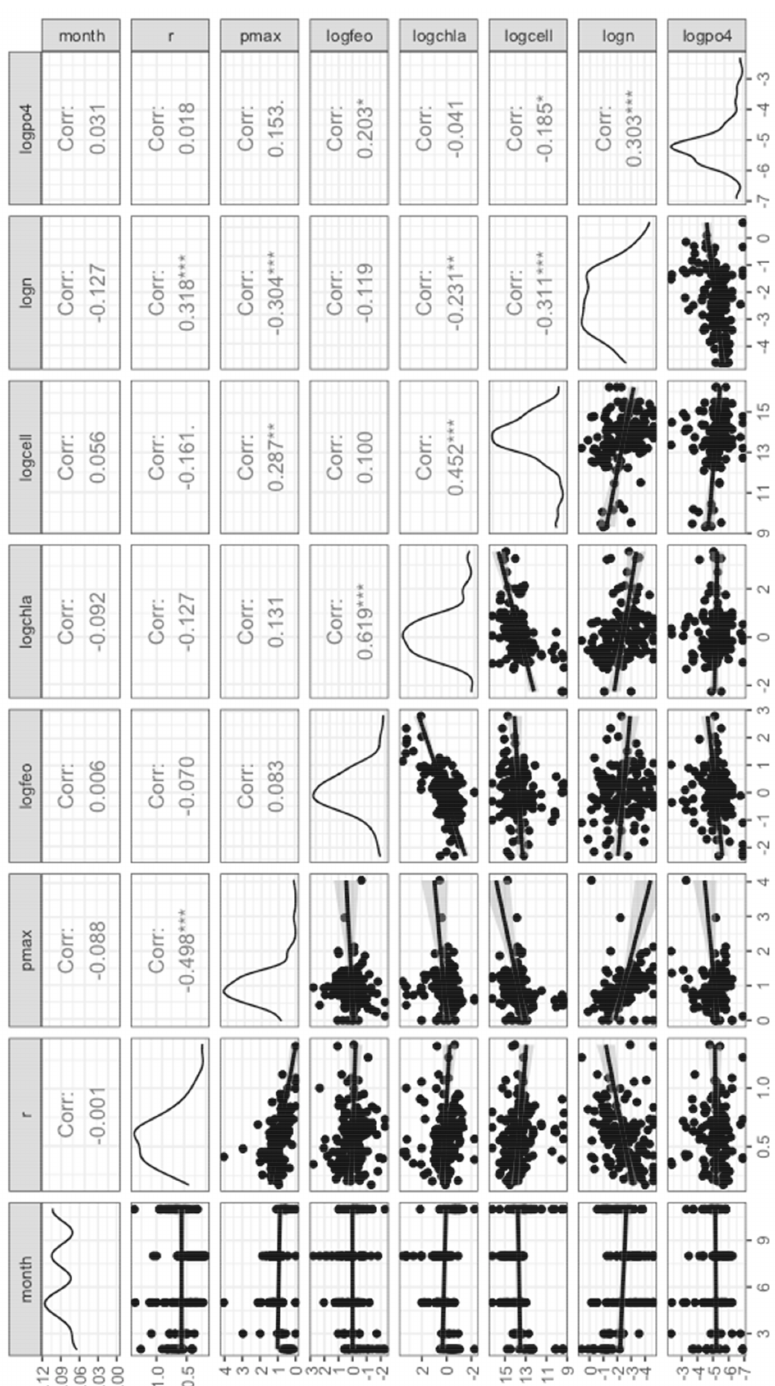
Figure 4. Correlation matrix displaying Pearson’s coefficients between sampling timing (month, year), model output ( r , pmax ) and field measurements of plankton indicators (phaeopigments, chlorophyll-a, number of plankton cells) and nutrients (inorganic nitrogen and phosphorous). Stars indicate significance levels (no stars: N.S’.’ < 0.09, ‘*’ < 0.05, ‘**’ < 0.01, ‘***’ <